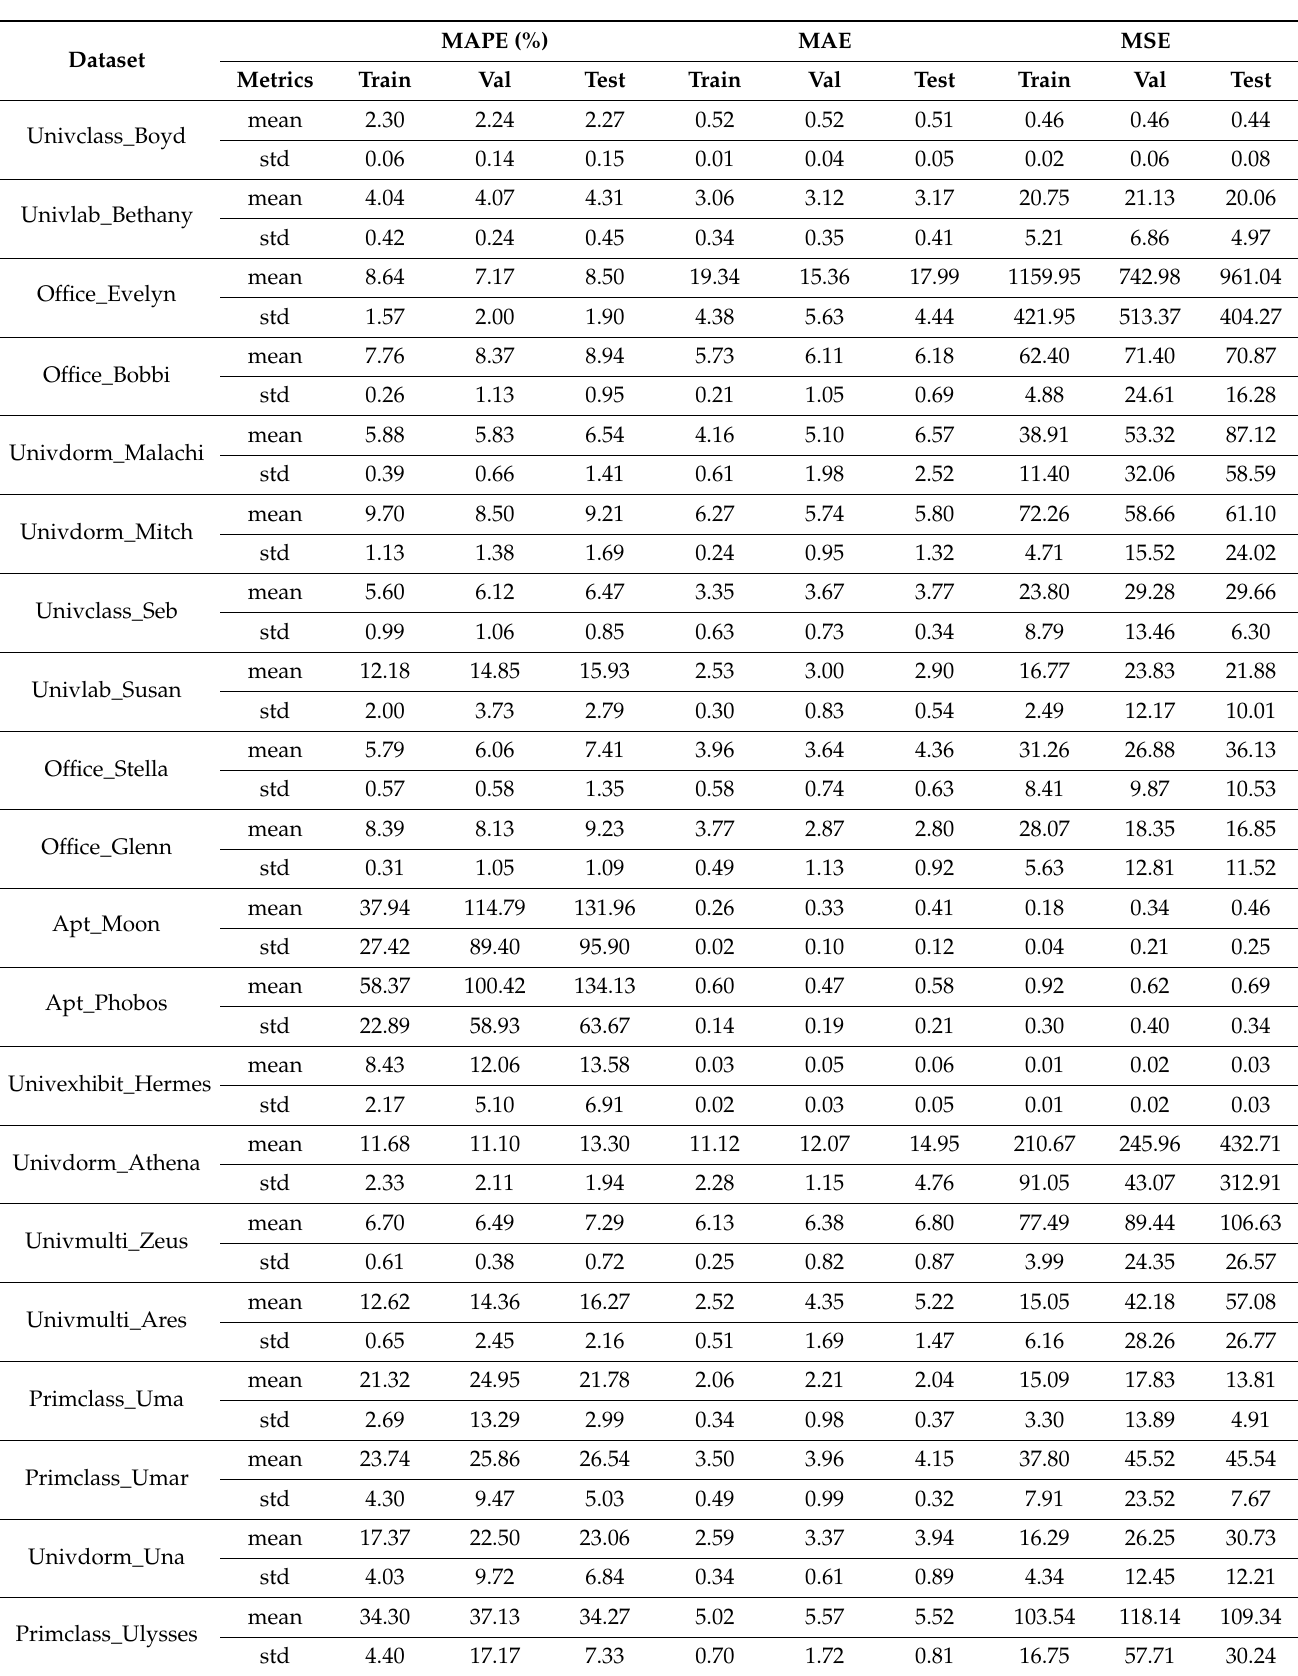
Table 15. The cross-validation result of forecasting using